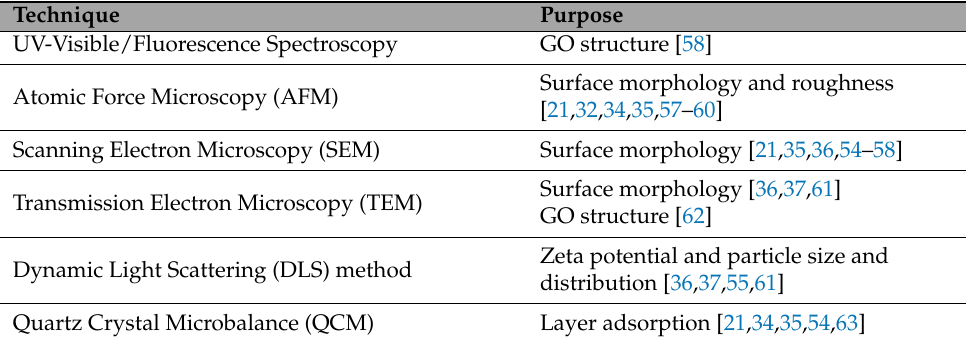
Table 1. Compilation of different techniques used to characterize the assembly of LbL films which contain